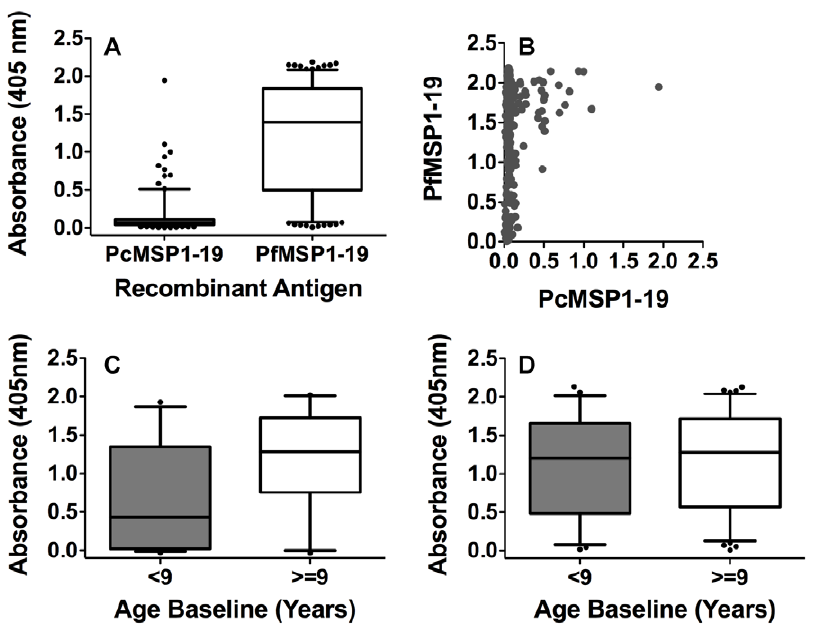
Figure 1. MSP1-19 IgG levels measured by ELISA and associations with age and parasitemic status at baseline bleed. ( A ) IgG reactivity against recombinant PcMSP1-19 and PfMSP1-19 for 206 Mugil plasma samples as measured by ELISA. ( B ) Correlation between levels of PcMSP1-19 and PfMSP1-19 IgG reactivity measured by ELISA for individual Mugil plasma. Levels of PfMSP1-19 specific IgG (PfMSP1-19 absorbance at 405 nm minus PcMSP1-19 absorbance at 405 nm) for children , 9 years or $ 9 years of age (Median 9.3 years, 41% of children , 9 years) at the baseline bleed separated based on ( C ) P. falciparum negative (n=67) or ( D ) P. falciparum positive (n=139) infection status identified by PCR at the baseline bleed. For A, C, and D, the bar and box represent median and IQR and whiskers represent the 5 th and 95 th